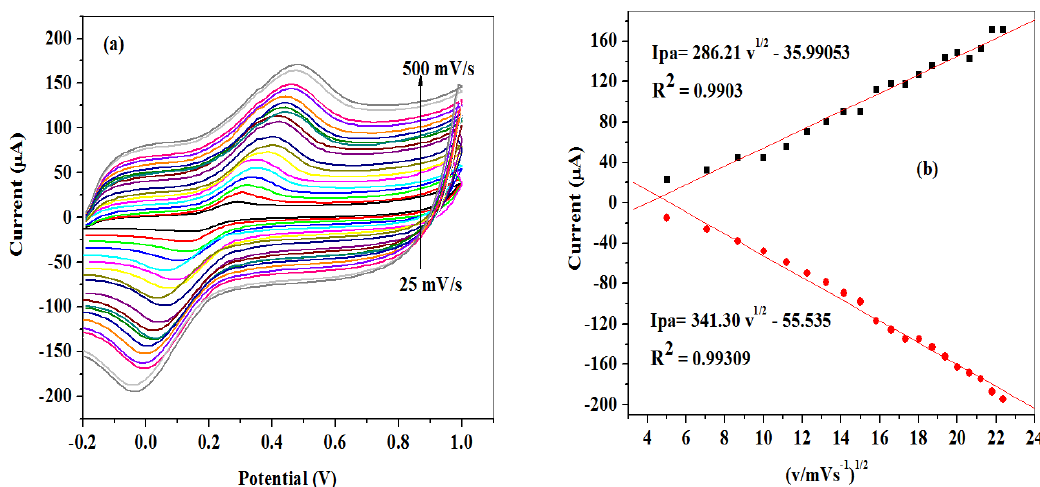
Figure 6. ( a ) Scan rate cyclic voltammograms of SPCE-Fe 3 O 4 /SPEEK. ( b ) Regression plot of peak currents versus square of scan rate in 5 mM K 3 [Fe(CN) 6 ] prepared in 0.1 M PBS (pH 7.4).